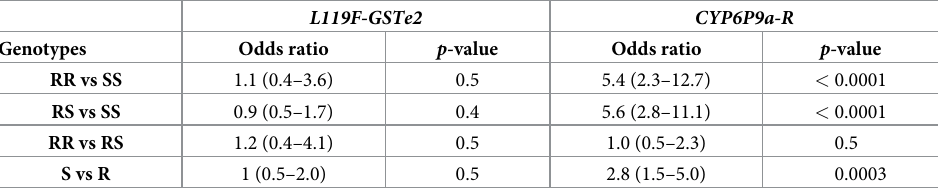
Table 1. level of association of L119F-GSTe2 and CYP6P9a -R genotypes with mosquito weight by comparing low (0–1.0mg) and high (1–2.4mg) weight